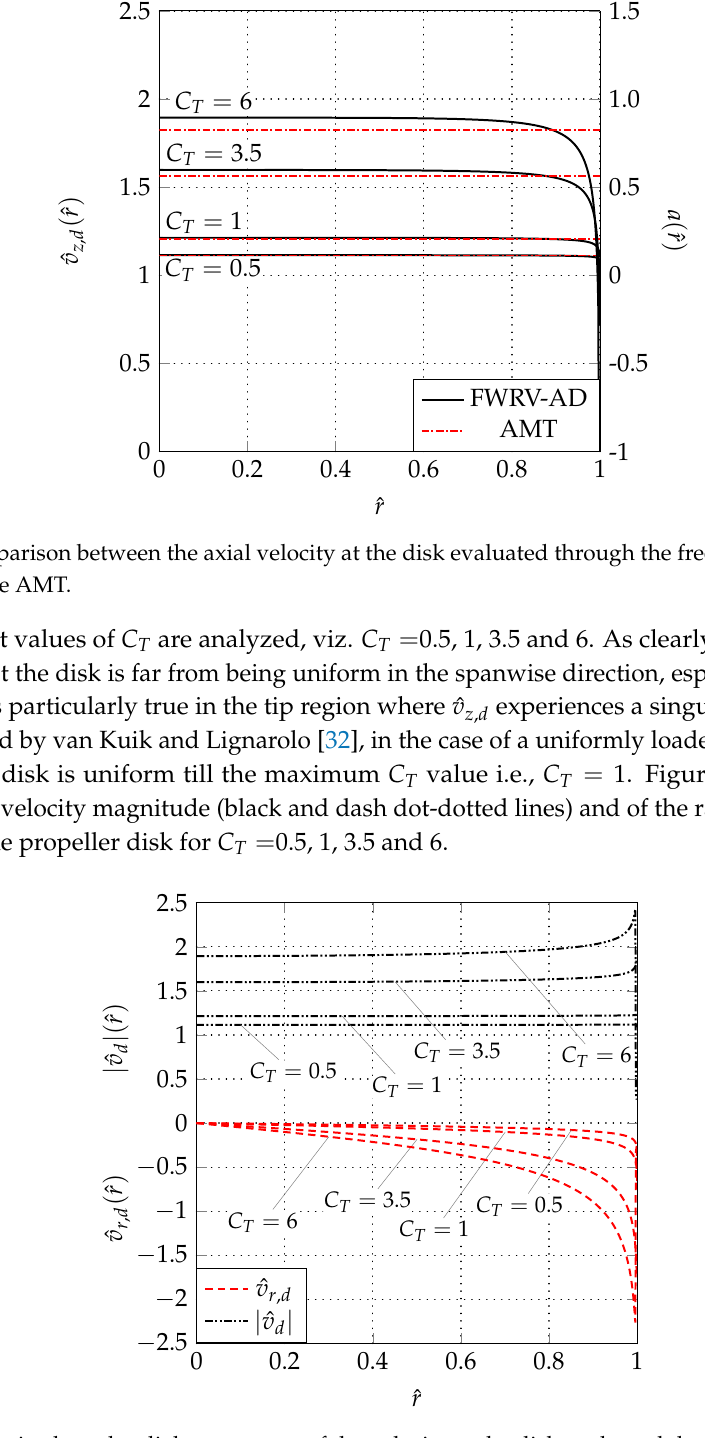
Figure 10. Magnitude and radial-component of the velocity at the disk evaluated through the free-wake ring-vortex